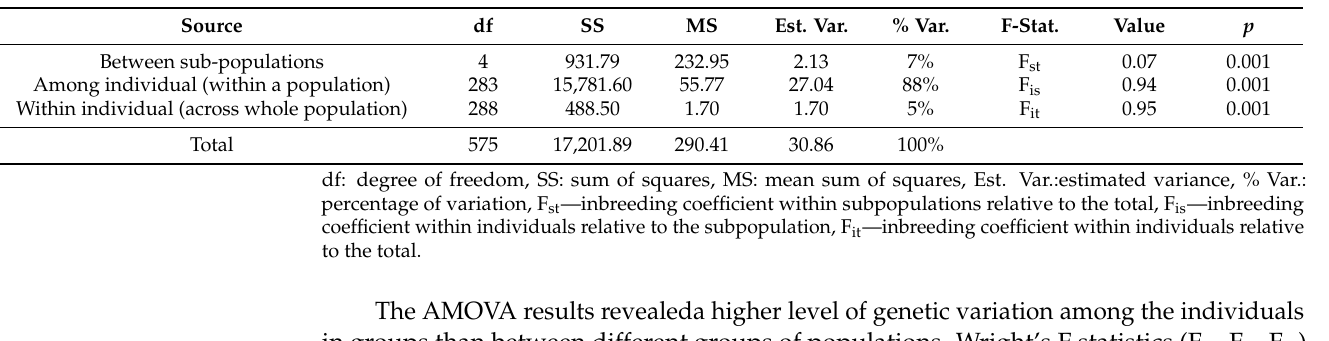
Table 2. Analysis of molecular variance (AMOVA) among 288 maize inbred lines based on 89 polymorphic SSR